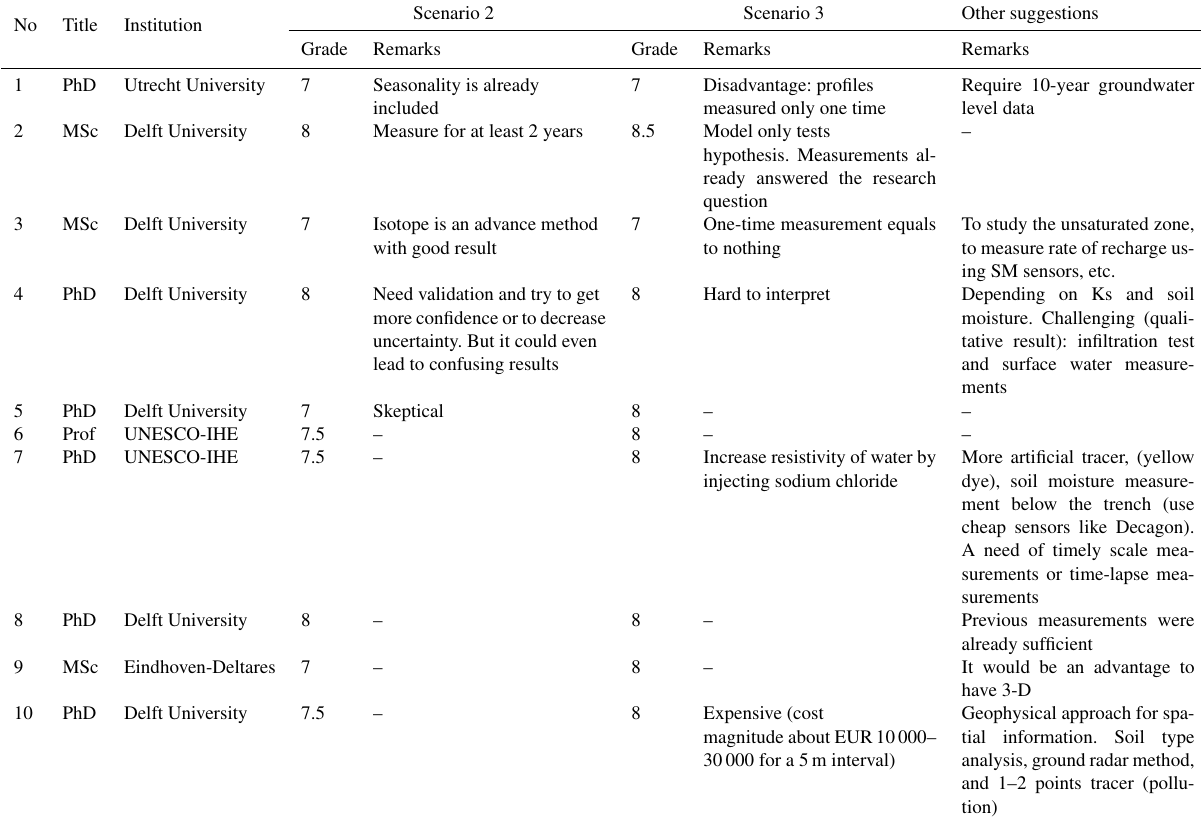
Table B1. Vietnam case: the experts’